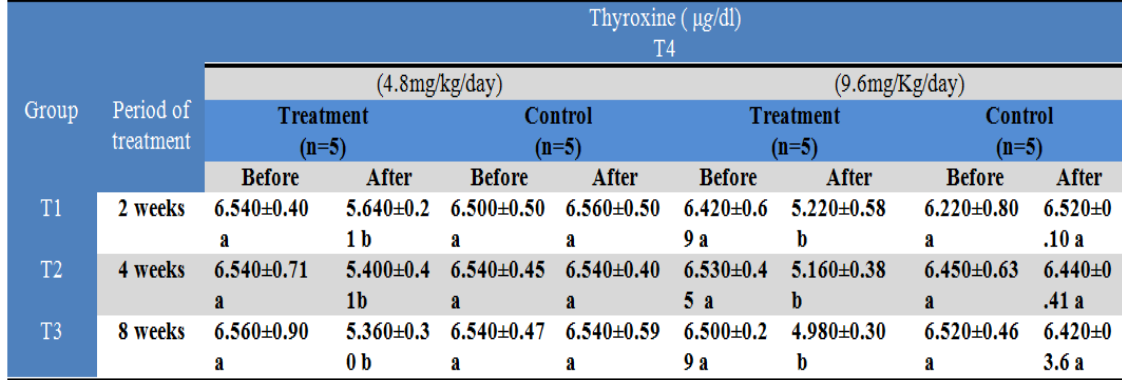
Table 3: Effect of orally administering a low dose (4.8mg/kg/day) and double dose